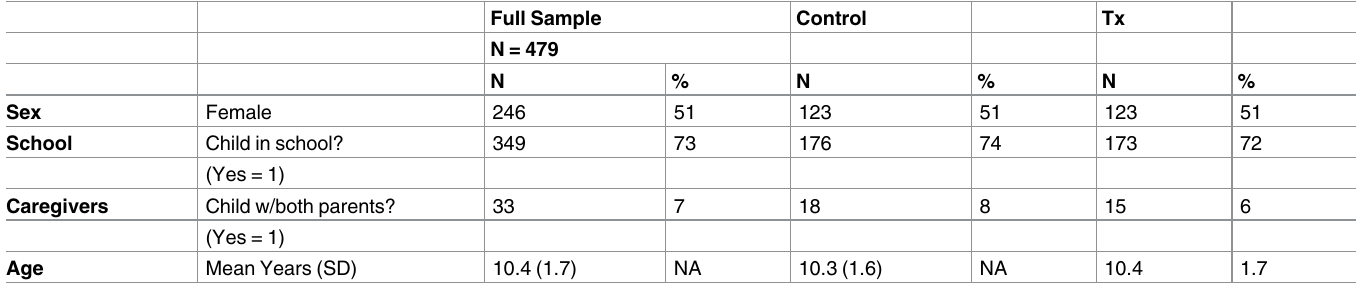
Table 3. Child demographics.